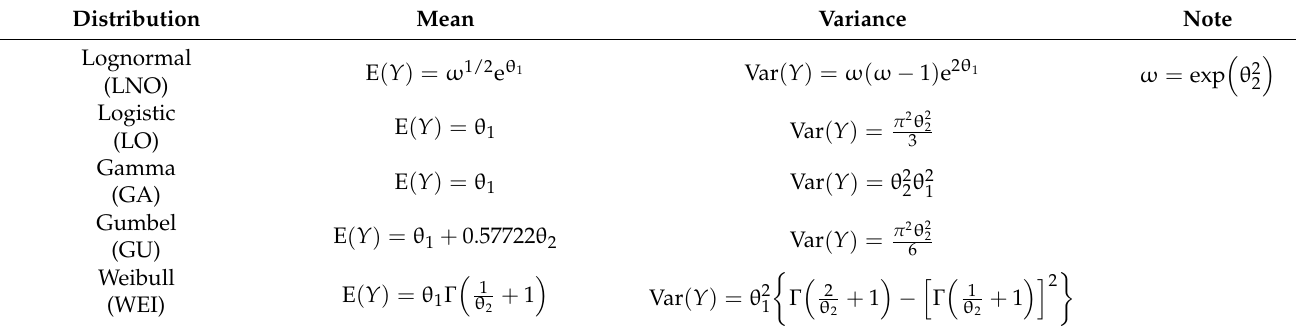
Table 2. Summaries of mean and variance of five distributions in terms of distribution